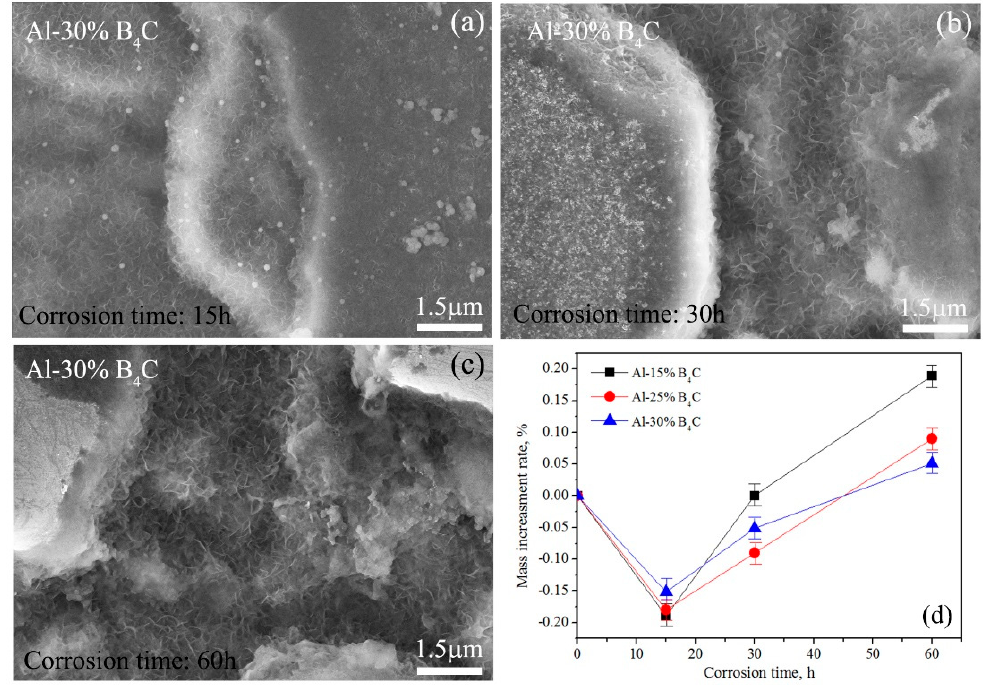
Figure 7. SEM images showing the surface morphology of Al-30%B 4 C MMCs corroded for ( a ) 15 h, ( b ) 30 h and ( c ) 60 h at 1000 ppm boric acid solution at 100 °C and atmospheric pressure; ( d ) The mass incensement rate vs. corrosion time of three kinds of Al/B 4 C MMCs.